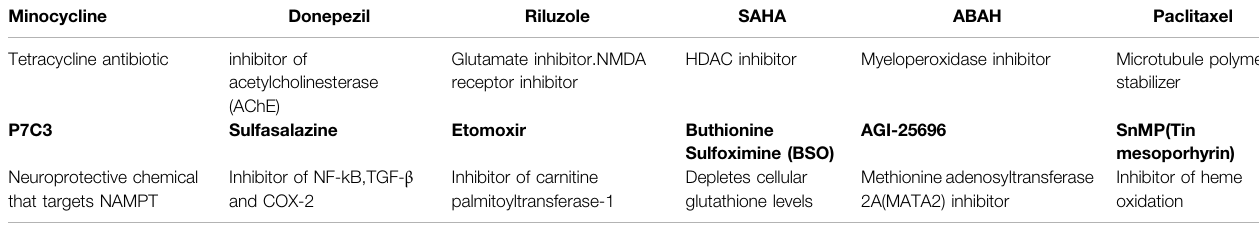
TABLE 1 | Overview of drugs and investigational compounds used with IMD platform for multiplex in situ drug response screen.